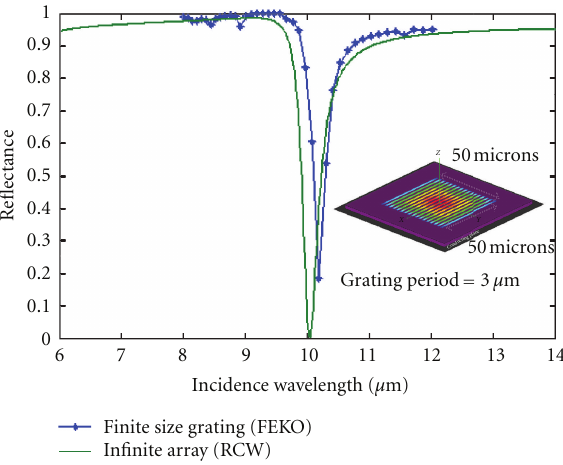
Figure 9: Predicted reflectance curves for a finite-sized particle compared to the infinitely periodic calculations. The edge e ff ects of the finite-sized sample are evident but do not significantly alter the resonant